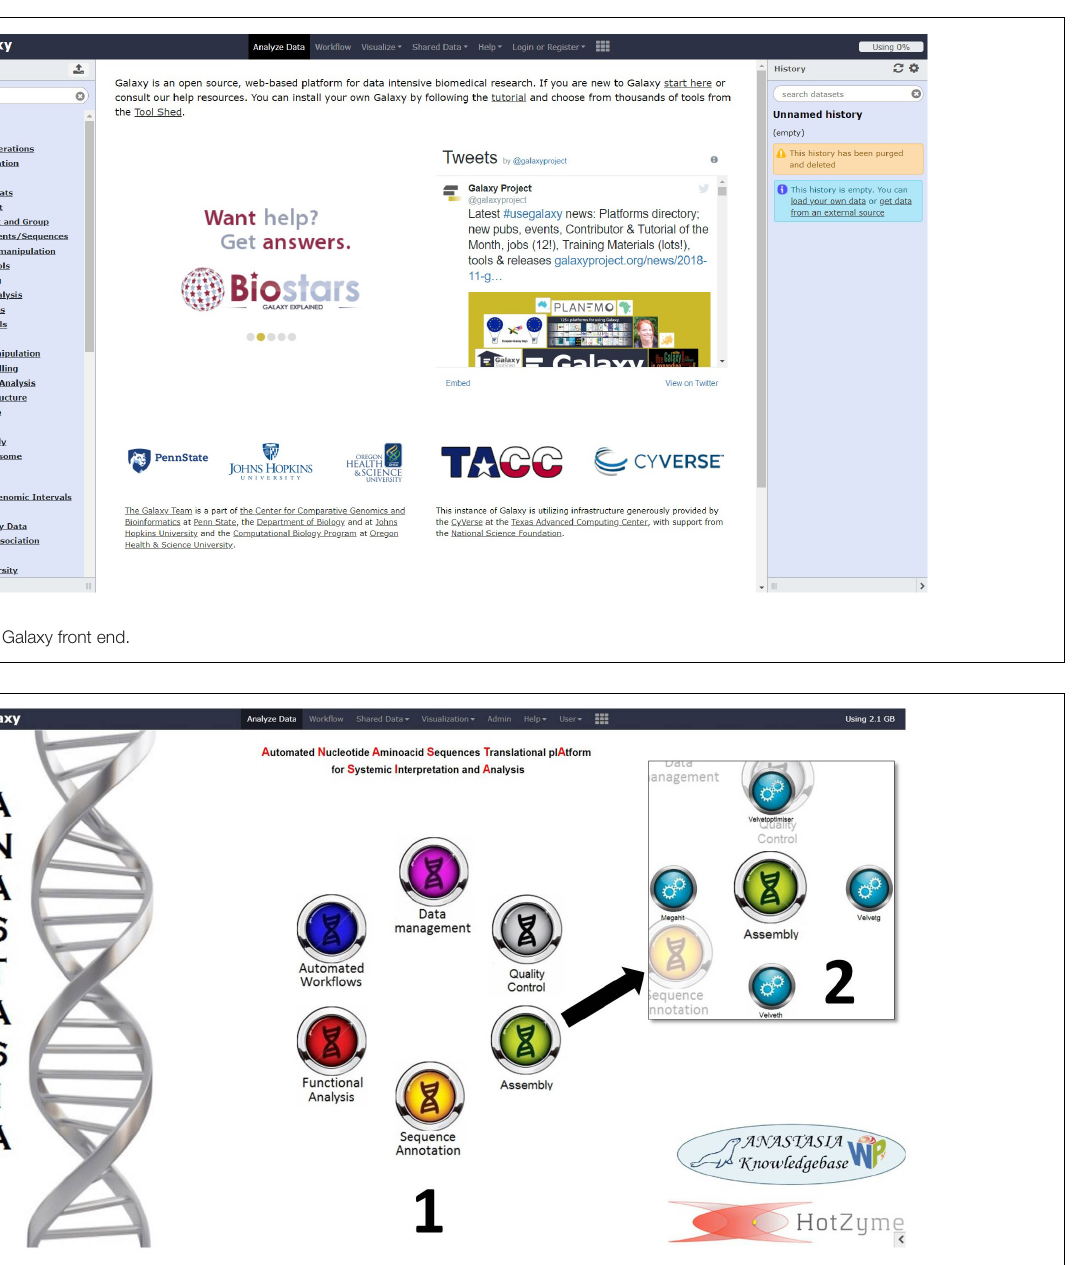
FIGURE 2 | The customized front page of ANASTASIA framework with (1) the main menu buttons and (2) the submenu of “Assembly” suite of tools. The submenu consists of 4 tools that handle NGS assembly from reads to contigs and a tool that imports the output assembly data into a MariaDB